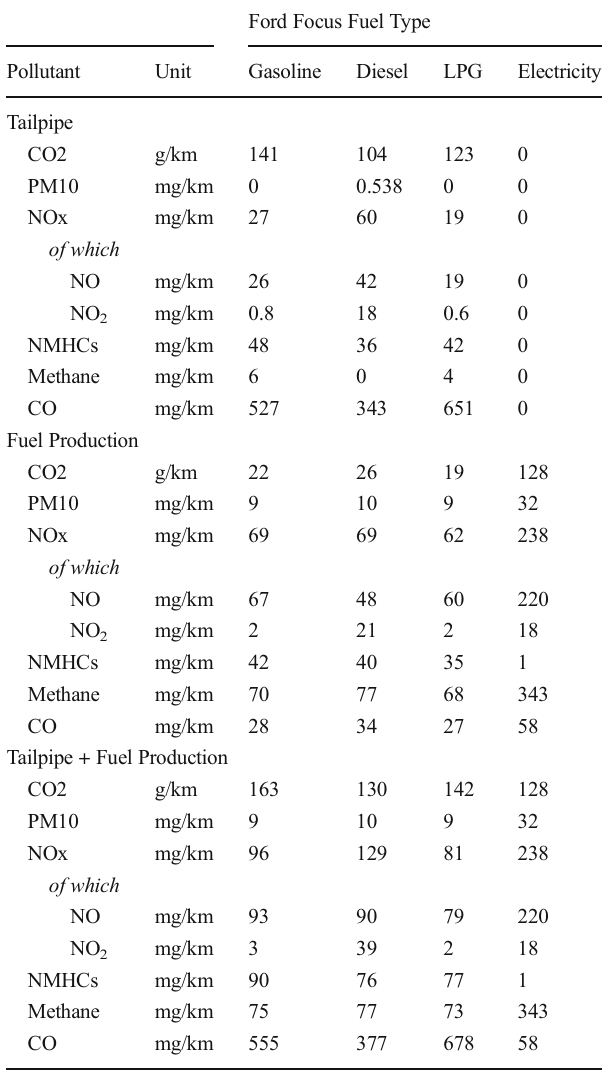
Comparison of Ford Focus emission inventories – gasoline, diesel, LPG and electricity